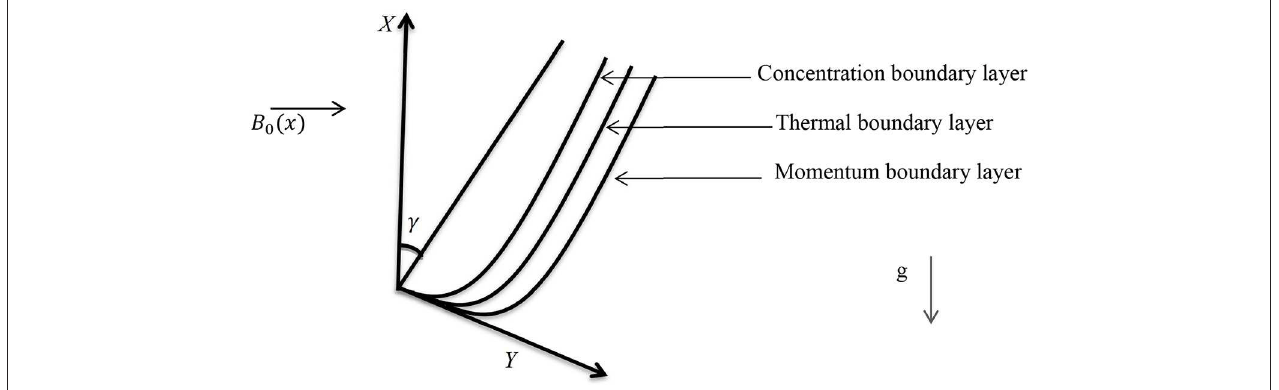
FIGURE 1 | Physical geometry and coordinate